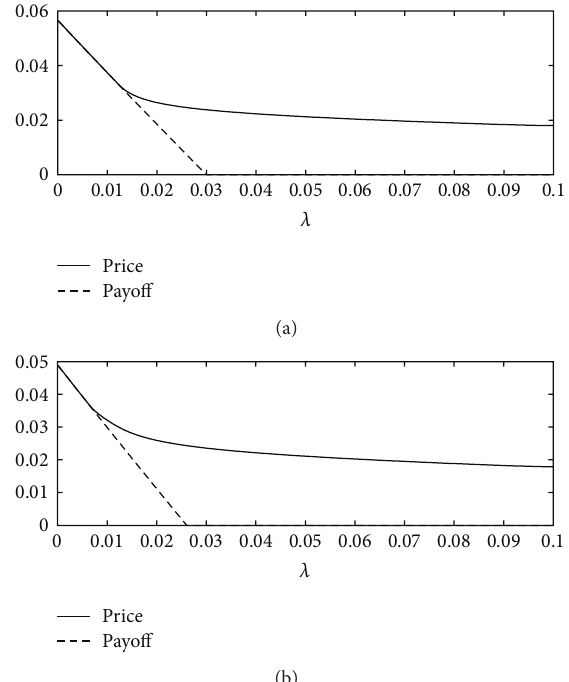
Figure 6: The price of the prepayment option 𝑃 Λ ∗ (𝜆) (solid line) and the payoff 𝜒(𝜆) (dashed line) as a function of the intensity 𝜆 . (a) Regime 𝑋 = 𝑒 1 ; (b) regime 𝑋 = 𝑒 2 . For each regime two regions appear: the continuation region 𝜆 > Λ ∗ 𝑖 and the exercise region 𝜆 ≤ Λ ∗ 𝑖